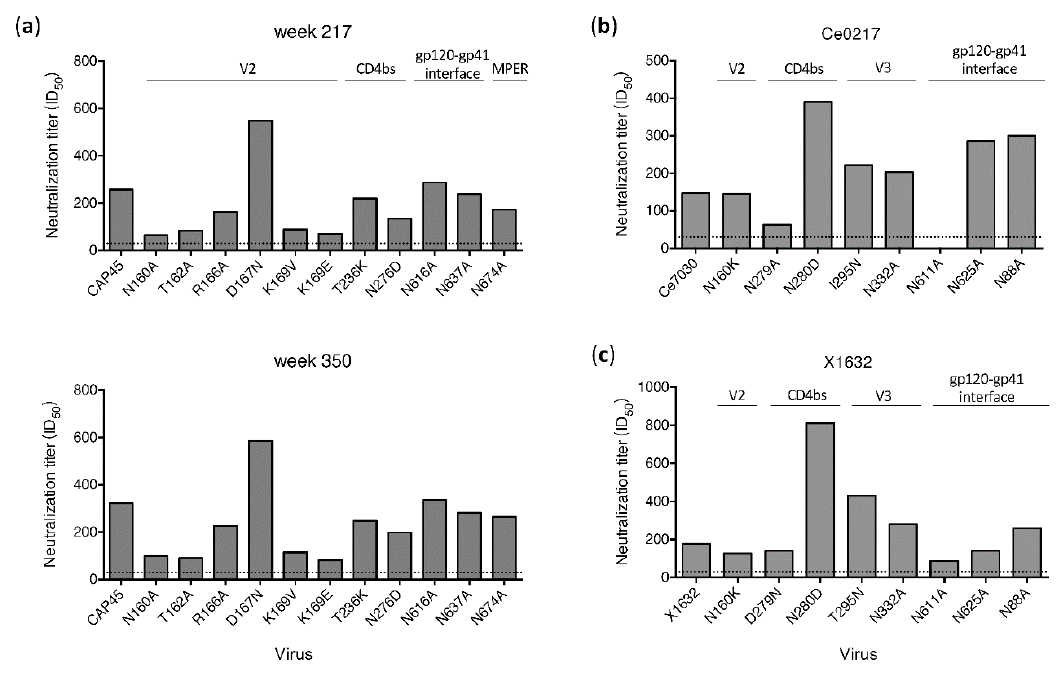
Figure 3. Determination of neutralization specificities of plasma from G1015R using different viruses. ( a ) Neutralization activities of plasma samples from week 217 and 350 post infection were determined using CAP45 and its env mutants. Neutralization activities of the week 350 plasma were determined against the Ce0217 ( b ) and X1632 ( c ) mutant sets with mutations in the V2, CD4bs, V3 and gp120-gp41 interface regions. The dotted line indicates the lowest dilution (1:30) for neutralization assay.